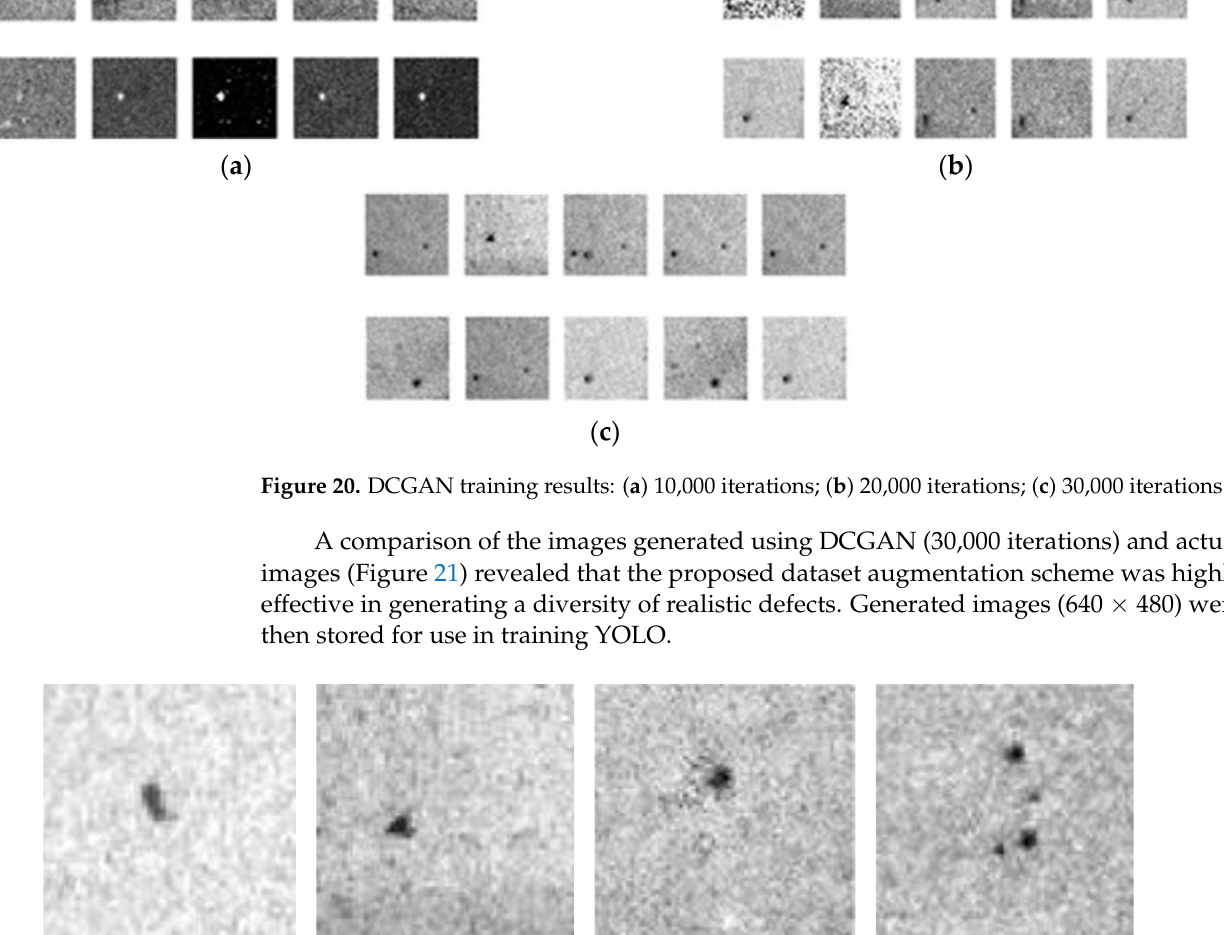
Figure 19. GAN training results: ( a ) 10,000 iterations, ( b ) 20,000 iterations, and ( c ) 30,000 iterations. Figure 20a, 20b, and 20c respectively present the results of DCGAN after 10,000, 20,000, and 30,000 iterations. After 10,000 iterations, the image has gradually become a prototype. After 20,000 iterations, the noise began to interfere with the features of the de- fects; however, the outline of the defects remained discernable. After 30,000 iterations, the flaws are easily discerned, and the images with less noise are indistinguishable from the original samples, which indicates that DCGAN achieved convergence.